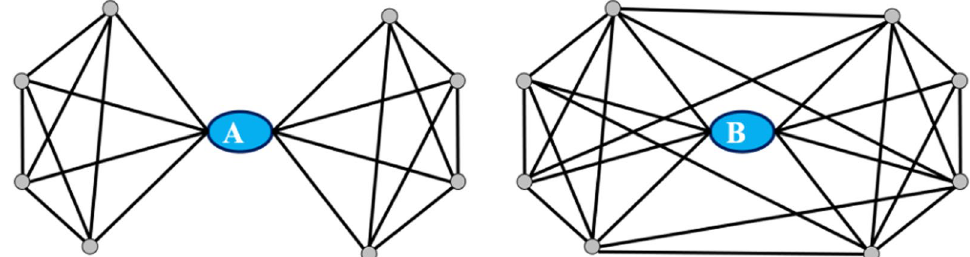
Fig. 1 Individuals within a bridging role serve to connect individuals who would otherwise not be connected. Person A serves as a bridge in their network, while person B does